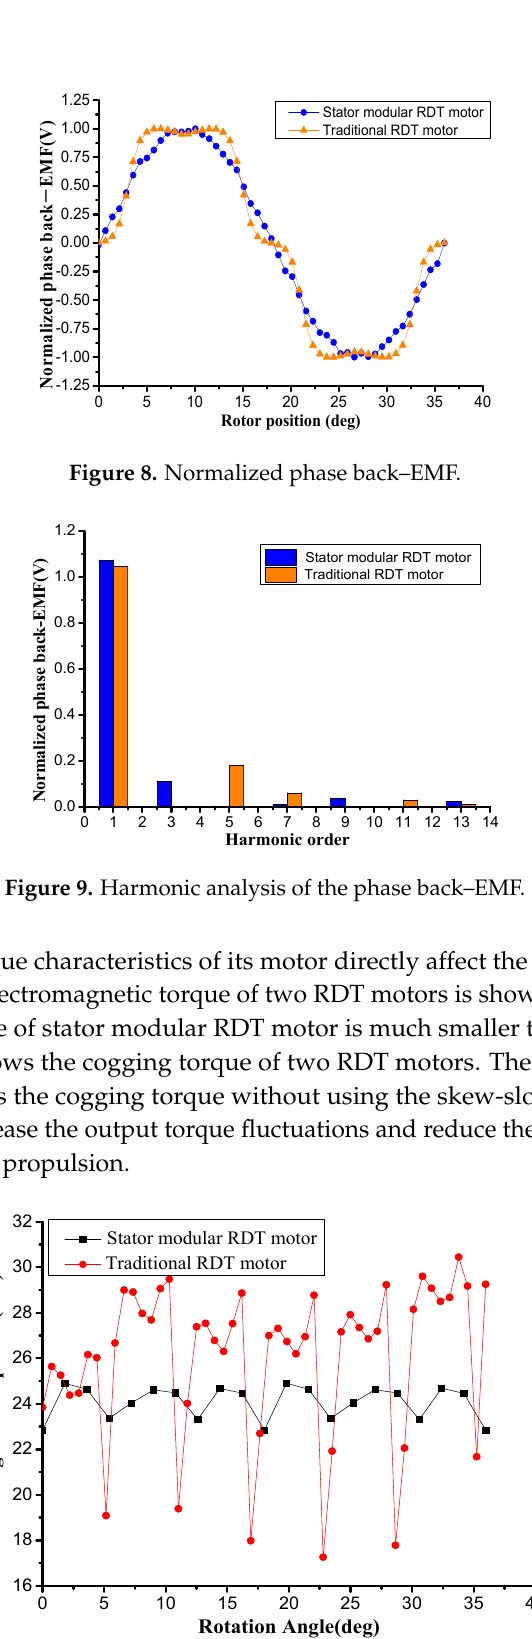
Figure 10. Electromagnetic torque.